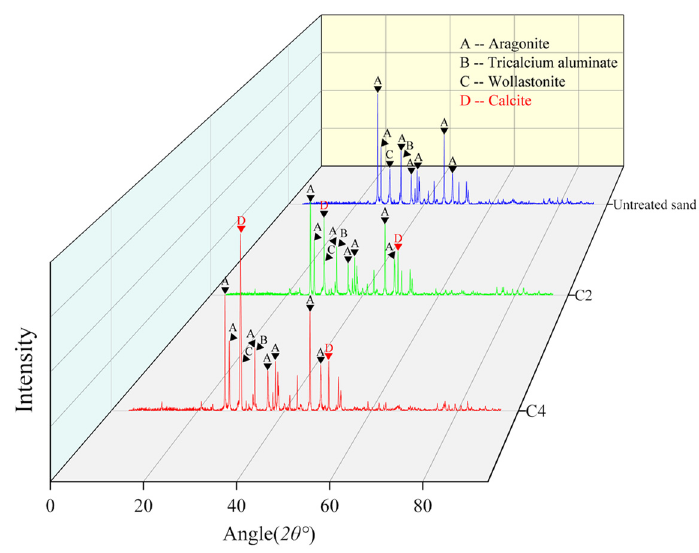
Figure 14. XRD analysis results of